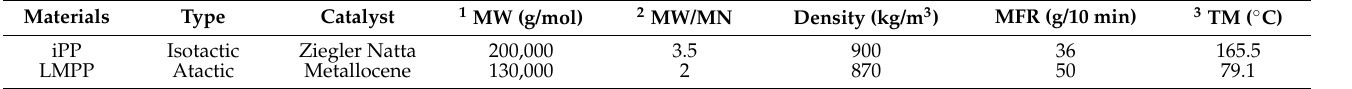
Table 1. Ingredients used for the